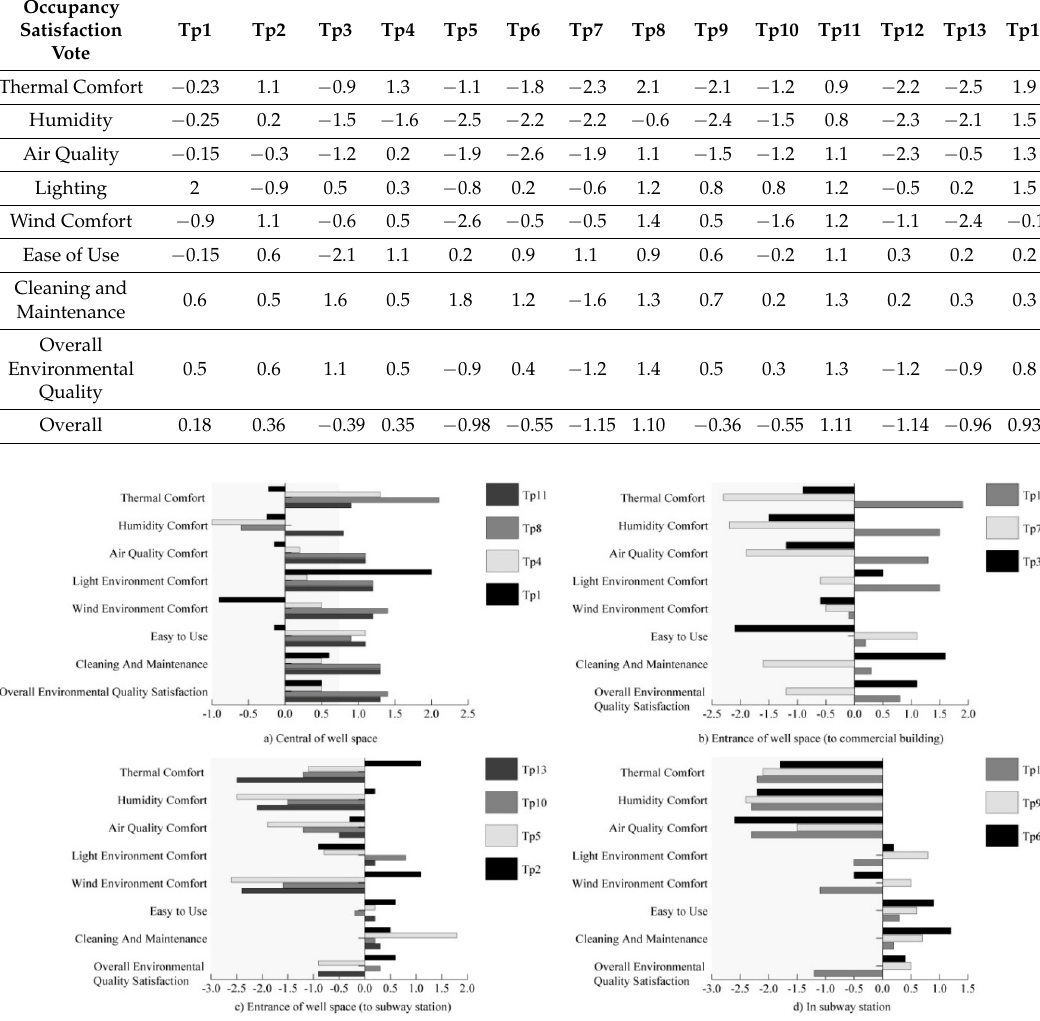
Figure 15. Results analysis of the occupancy satisfaction survey.